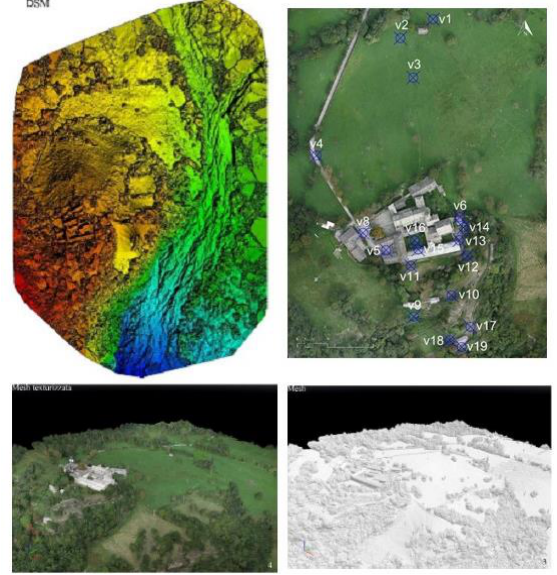
Figure 2. (Above left) Digital Surface model processed by Pix4Dmapper software. (Above right) Topographical network; (below) meshed model and textured meshed model. (Patrucco, 2016)